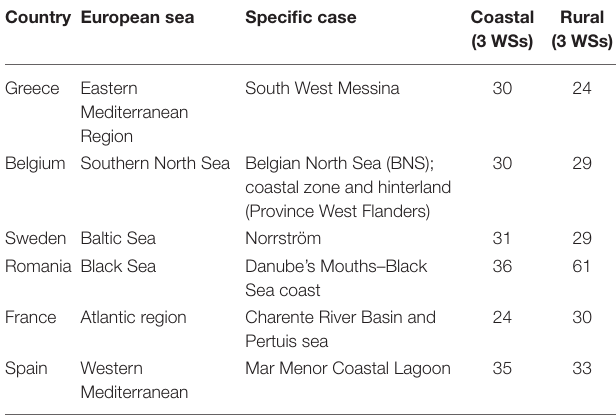
TABLE 1 | Overview of case areas and number of stakeholders in total in the